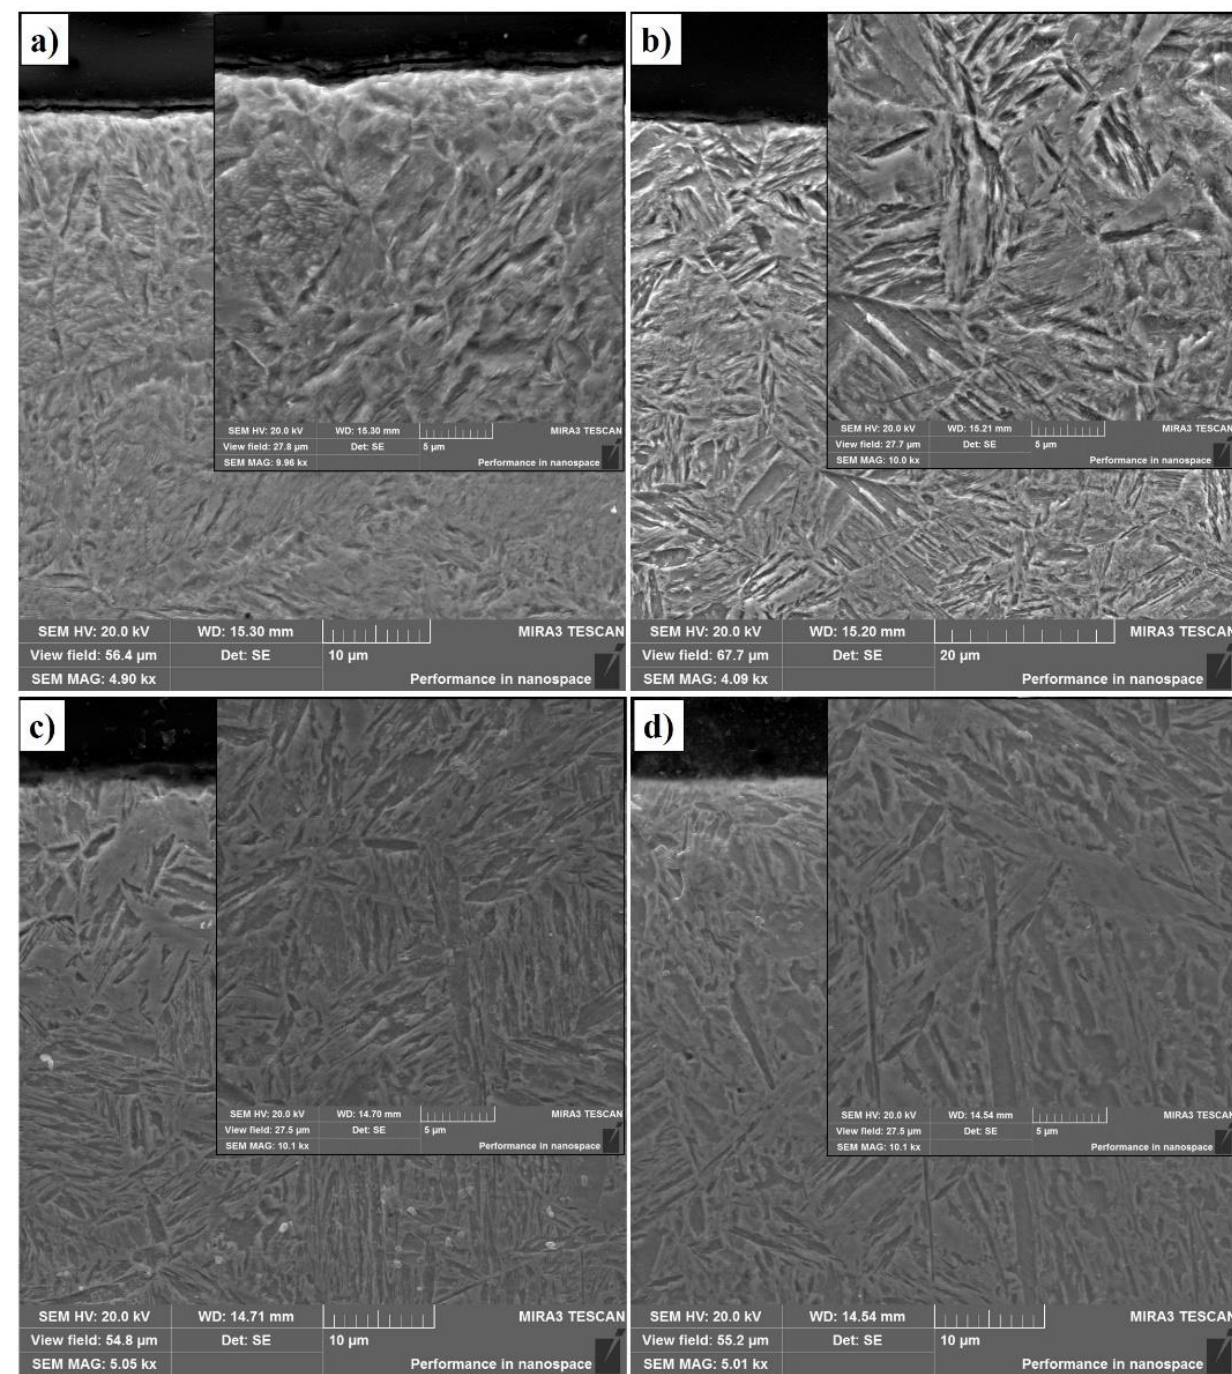
Figure 4. Microstructure of the 30CrMnSiA steel after EPTCH: ( a ) No. 1; ( b ) No. 2; ( c ) No. 3; ( d ) No. 4.